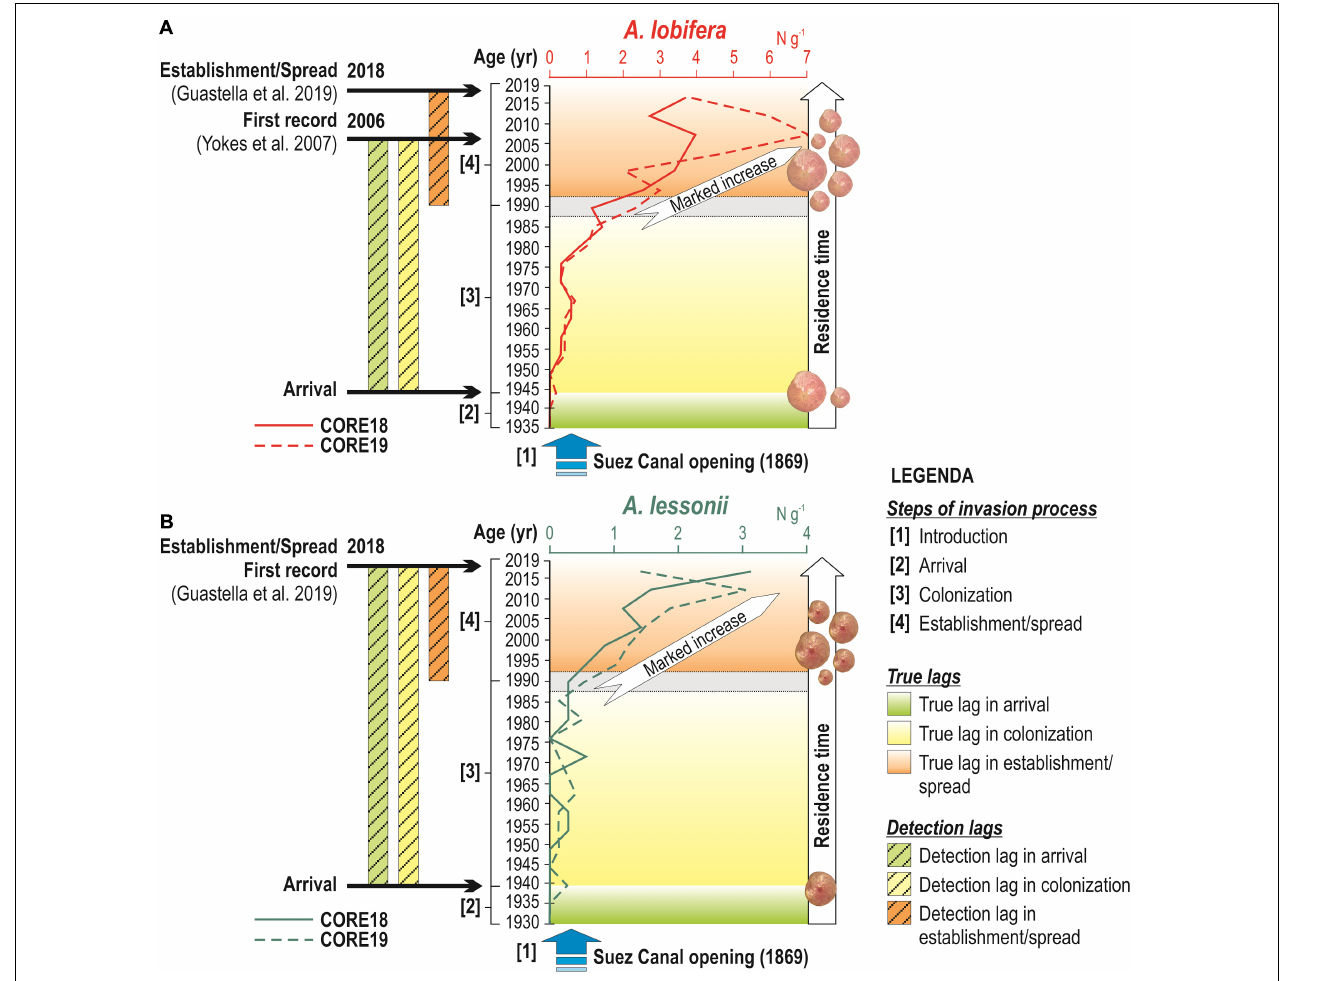
FIGURE 5 | Curves of absolute abundance of A. lobifera (A) and A. lessonii (B) with the different steps of invasion process (on the left): (1) introduction of the species after the opening of Suez Canal in 1869; (2) first arrival of A. lobifera occurred in the mid-1940s and of A. lessonii at the end of 1930s, respectively; (3) subsequent gradual colonization and (4) the establishment and population increase since the 1990s for both species. Compared to the real first arrival and the beginning of colonization process of A. lobifera , the first record documented in 2006 (Yoke¸s et al., 2007) occurred with a lag time of about 60 years. Guastella et al. (2019) reported the first record of A. lessonii in Malta in 2018, with a lag time of about 80 years and the establishment/spread of A. lobifera and A. lessonii with a lag time of about 30